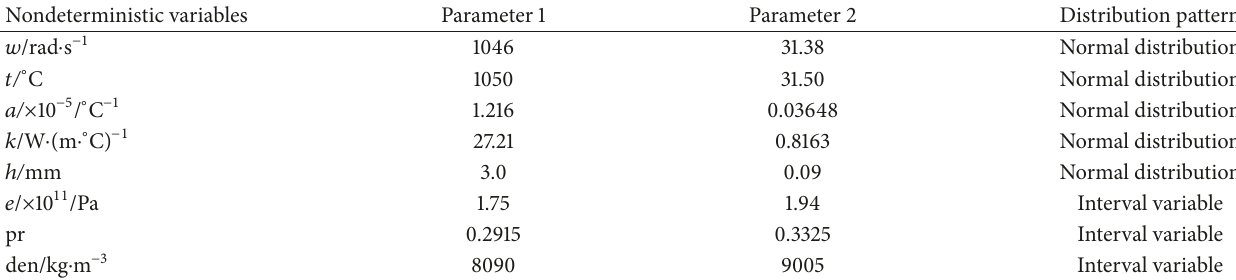
Table 1: Distribution of nondeterministic variables of tuned blisk.